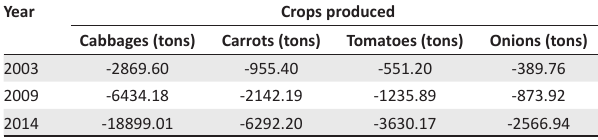
TABLE 3: Changes in quantities of production per type of vegetable crops. Year Crops produced Cabbages (tons) Carrots (tons) Tomatoes (tons) Onions (tons)